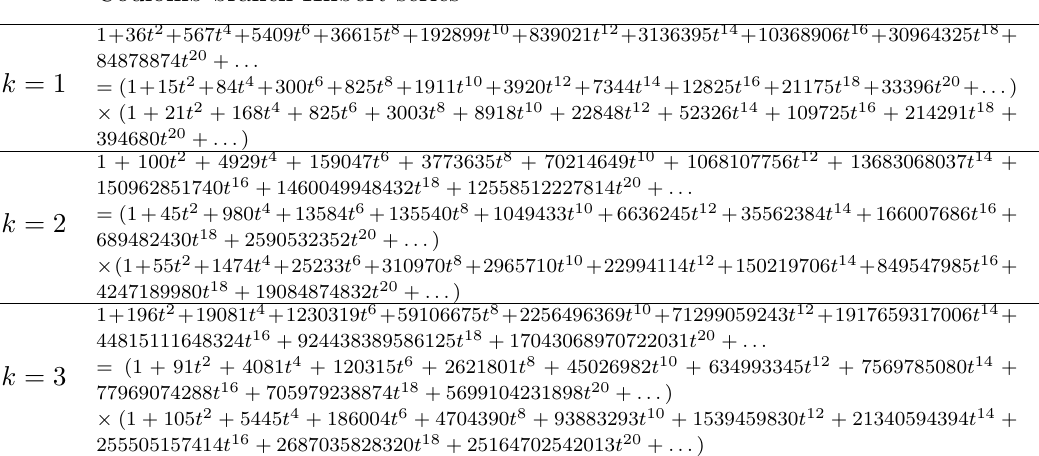
Table 20. Hilbert series results for (3.14). The first line displays the Coulomb branch Hilbert series for (3.14), while the second line displays the factorisation. Each factor agrees with the known Hilbert series for O so 4 k +2 and O so 4 k +3 , respectively. [2 2 k − 2 , 1 2 ] [2 2 k − 2 , 1 3 ]